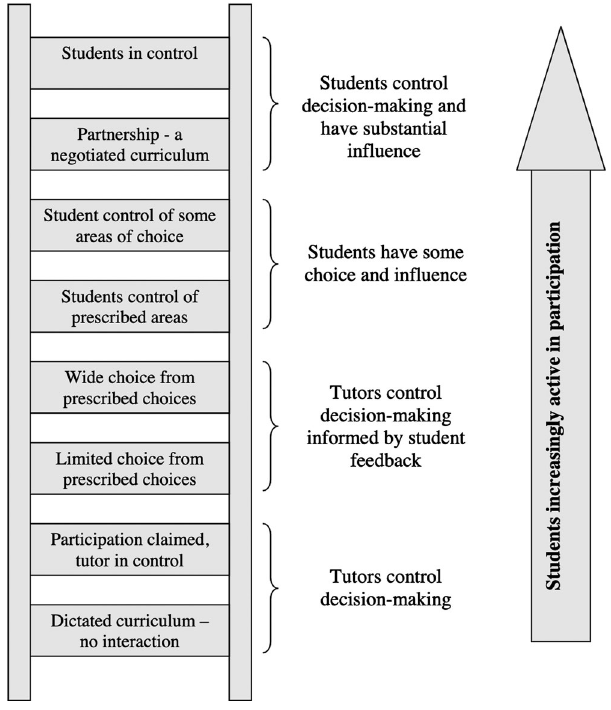
FIG. 1. LA participation ladder: a visualization of the different levels of influence that LAs can have on curriculum design and pedagogy. Borrowed from Bovill and Bulley [6] to conceptualize student-faculty relationships instead of student-tutor relation-